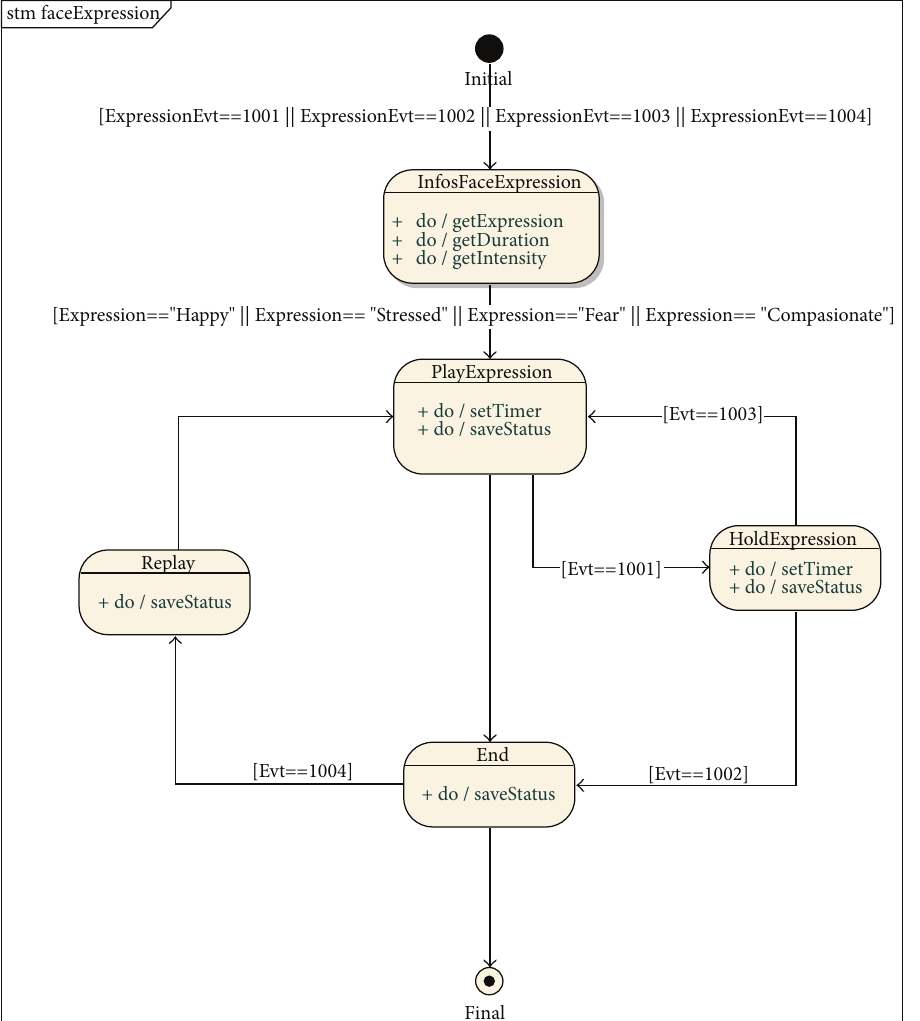
Figure 3: Avatars face animation